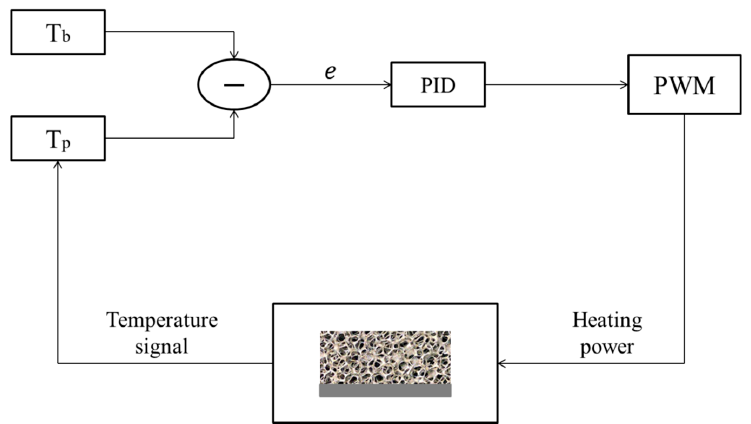
Figure 6. Schematic representation of the feedback system.